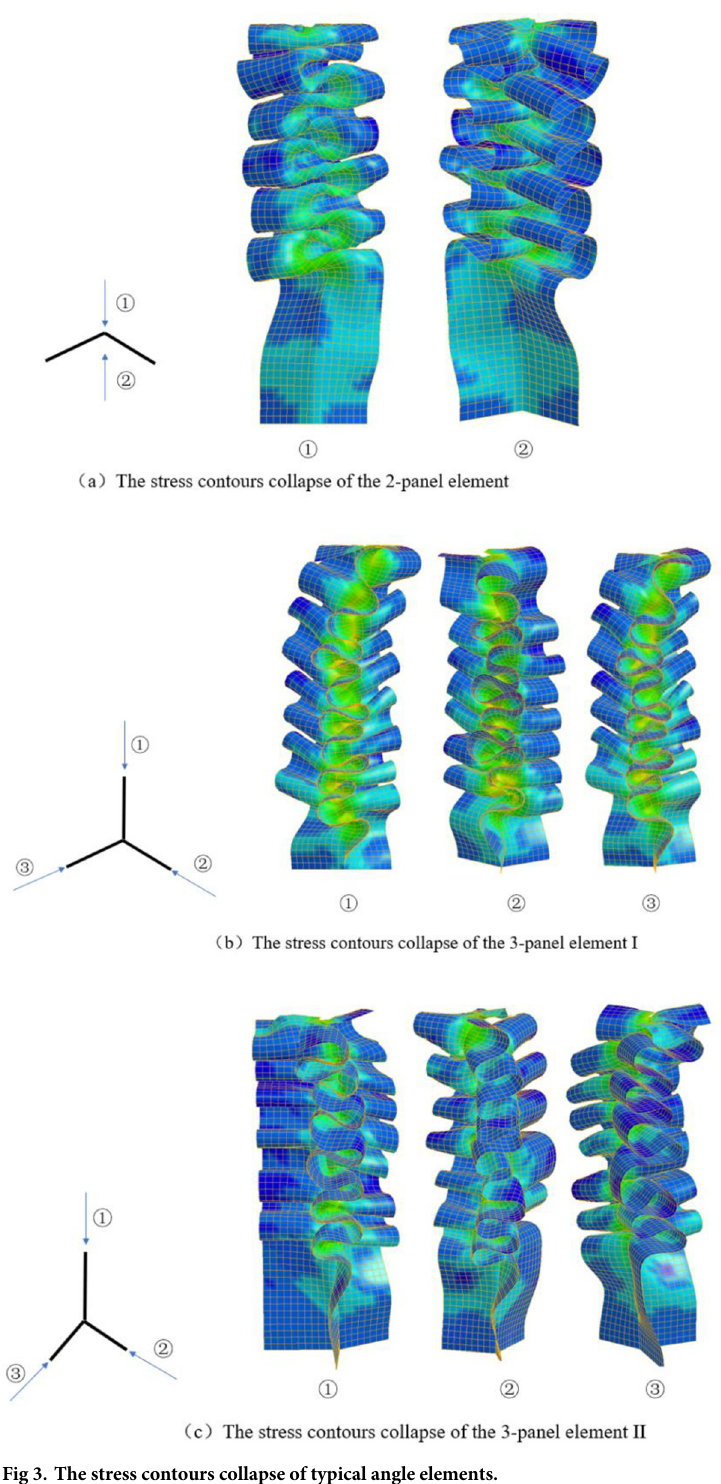
Fig 3. The stress contours collapse of typical angle